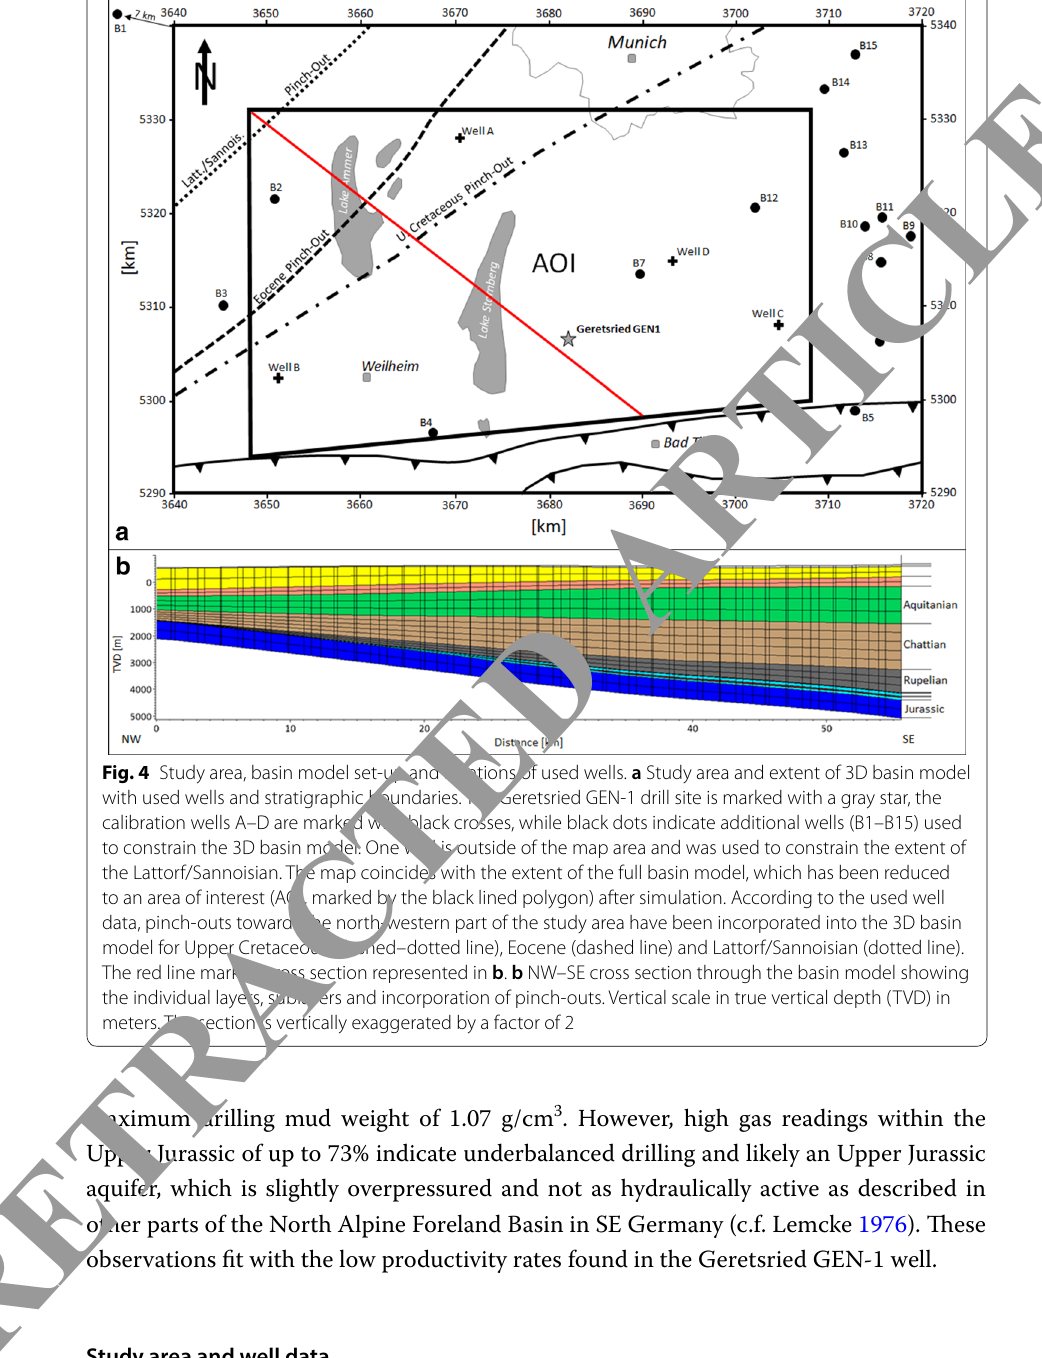
observations fit with the low productivity rates found in the Geretsried GEN-1 well.